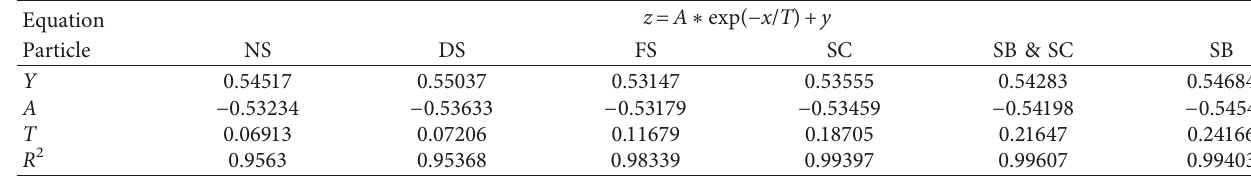
Table 5: The predicted and the measured values of ( e